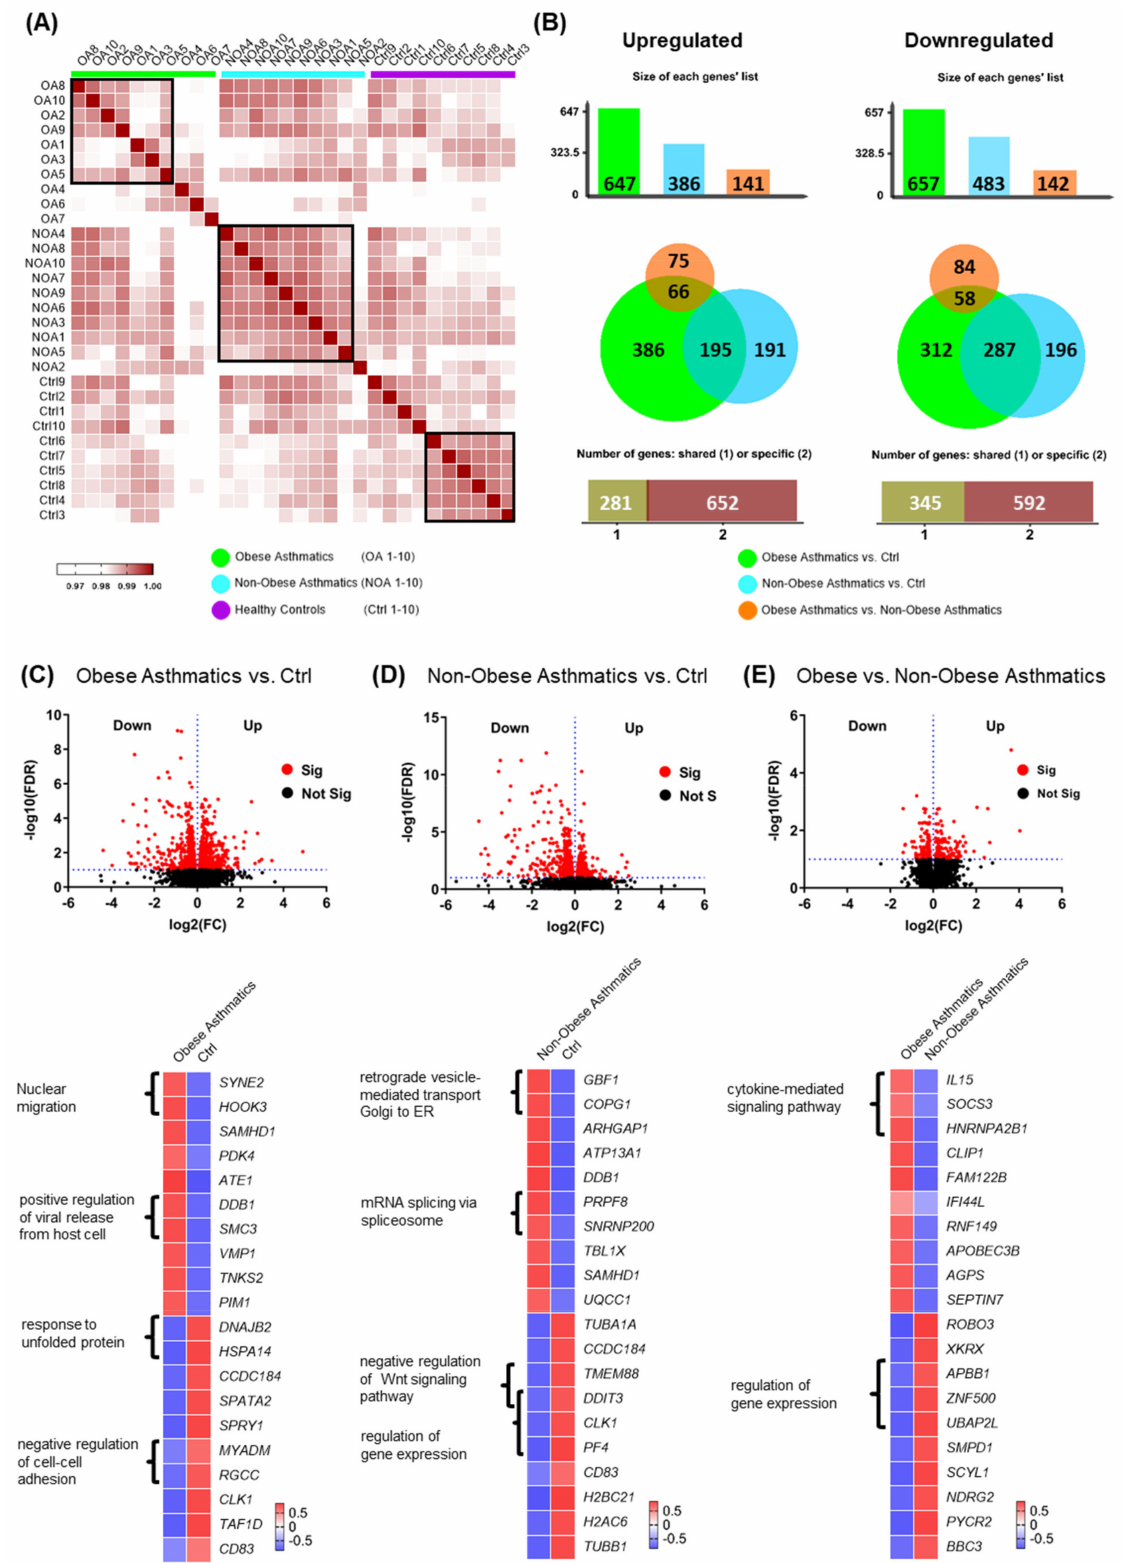
Figure 1. Differentially expressed genes of both low type-2 obese asthma and non-obese asthma phenotypes using a significance threshold cutoff for FDR < 0.1. ( A ) Correlation matrix of 75% of the detected genes for 10 obese asthmatics ”OA, green”, 10 non-obese asthmatics “NOA, turquoise”, and 10 healthy controls “Ctrl, purple”. ( B ) Proportional Venn diagrams showing the specific and shared genes of obese asthmatics vs. Ctrl (healthy controls), non- obese asthmatics vs. Ctrl, and obese asthmatics vs. non-obese asthmatics. ( C – E , up) Volcano plots presenting differentially expressed genes of the three comparisons. ( C – E , down) Heatmaps showing the top significantly 10 up and downregulated genes with some of the associated biological processes (GO terms, p <